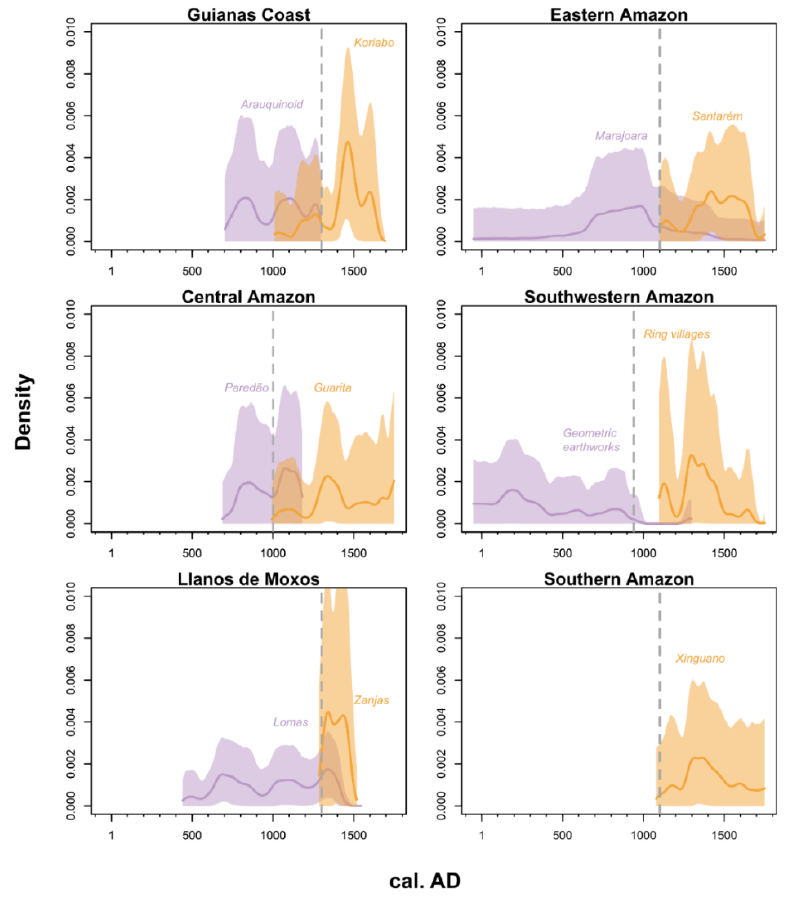
Figure 3. Bootstrapped composite kernel density estimates by region. Colouration follows the same convention as previous figures. Shaded areas are the 95% confidence intervals around the data, solid lines indicate the confidence interval mean. Dashed vertical lines indicate the start of named climate events in each region following De Souza et al. [1].